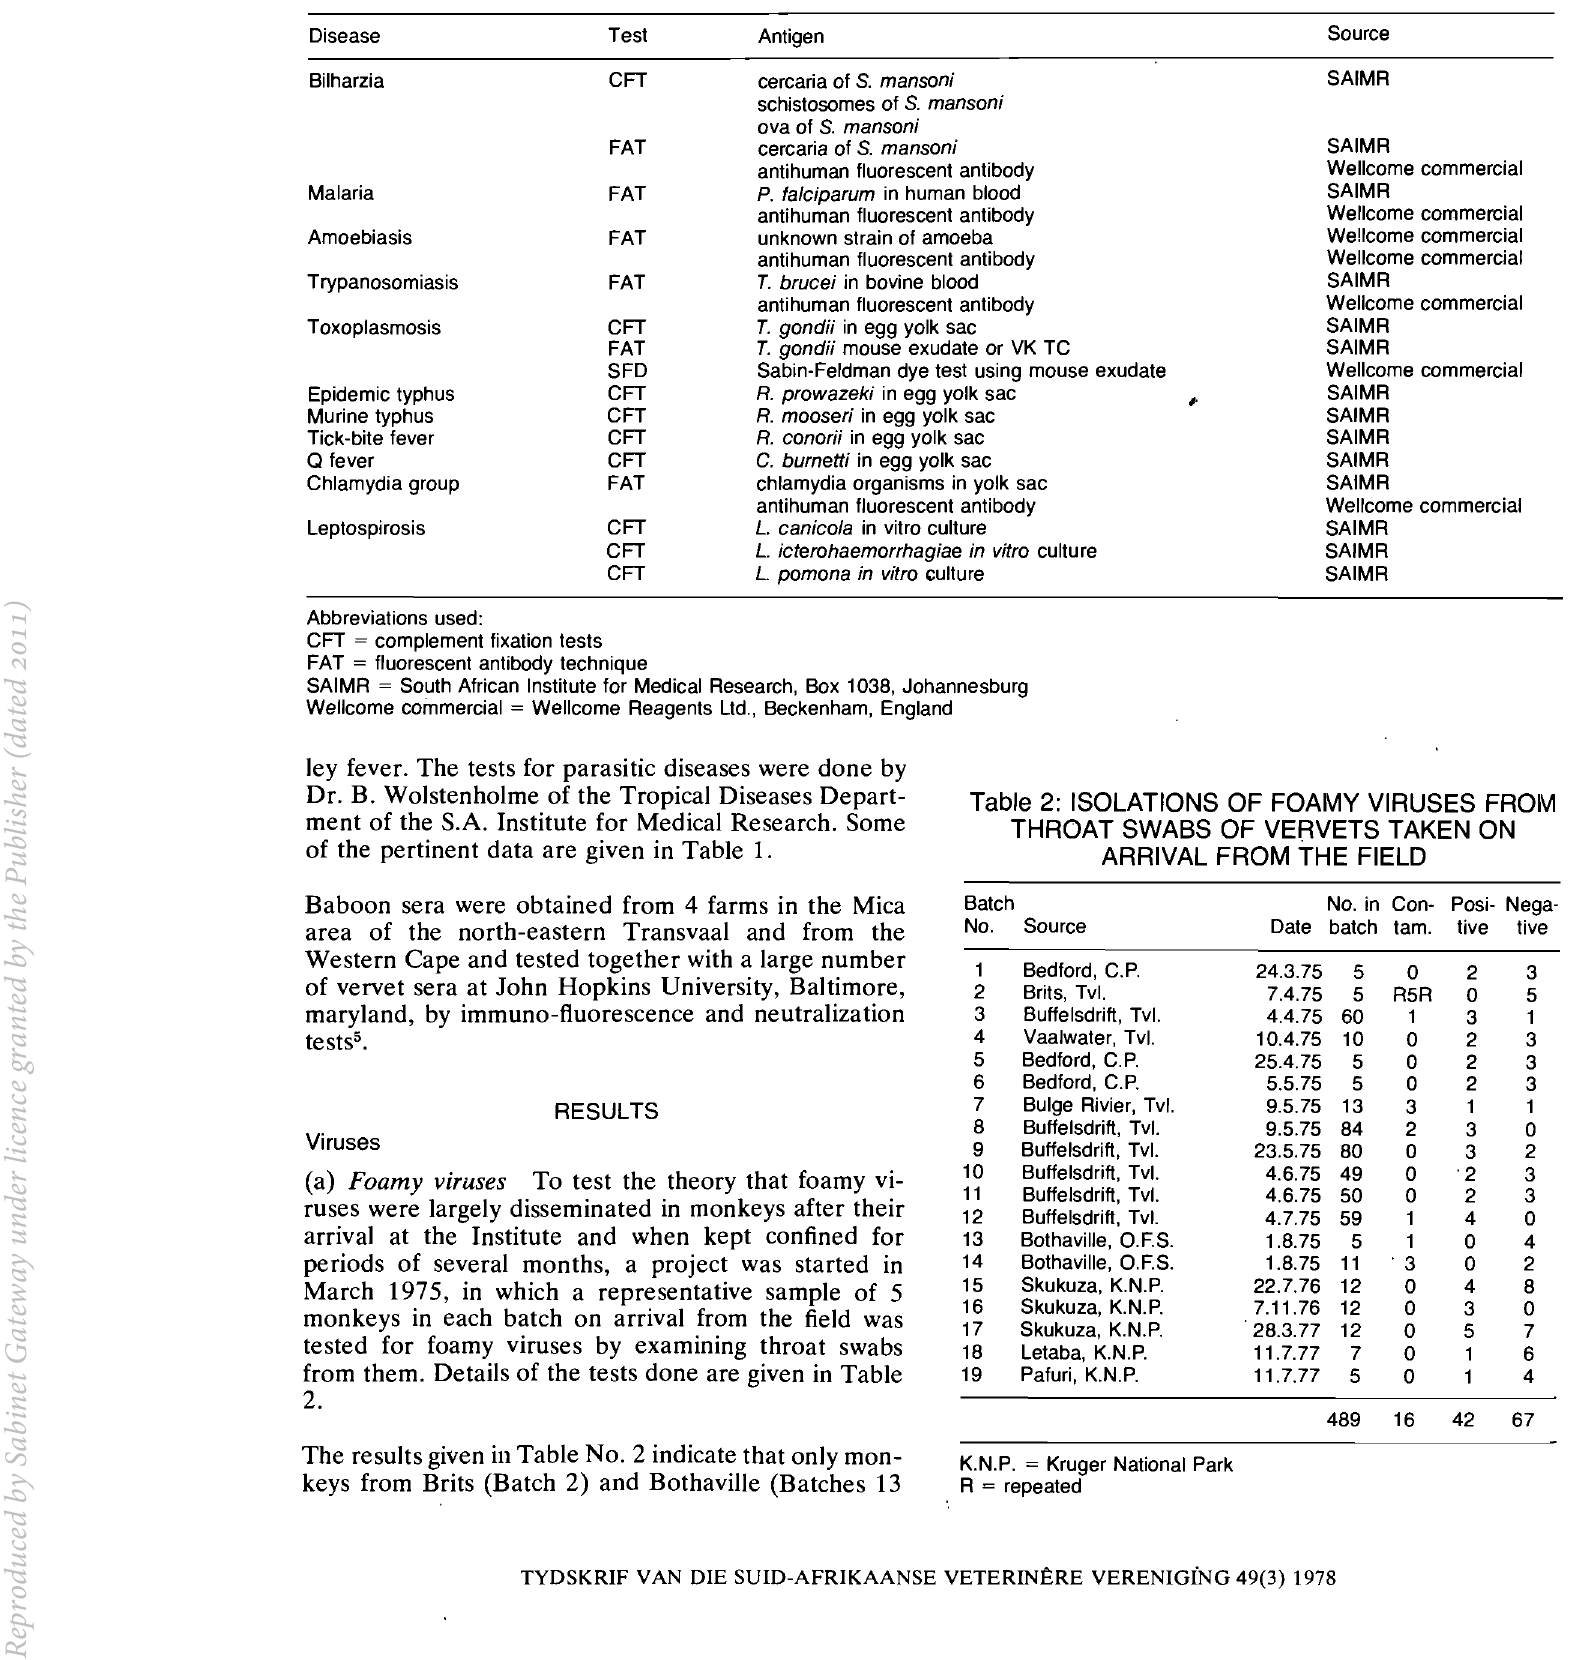
Table 1: SOME OF THE ANTIGENS USED IN THE TESTS FOR PARASITIC DISEASES